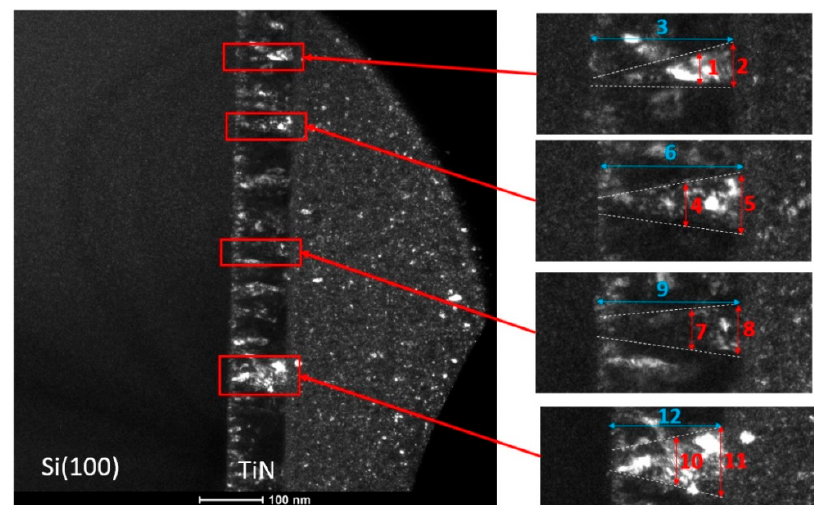
Figure 8. TEM images with marked investigated locations. Table 2. Measured columns’ dimensions in the TiN thin film (width, height).